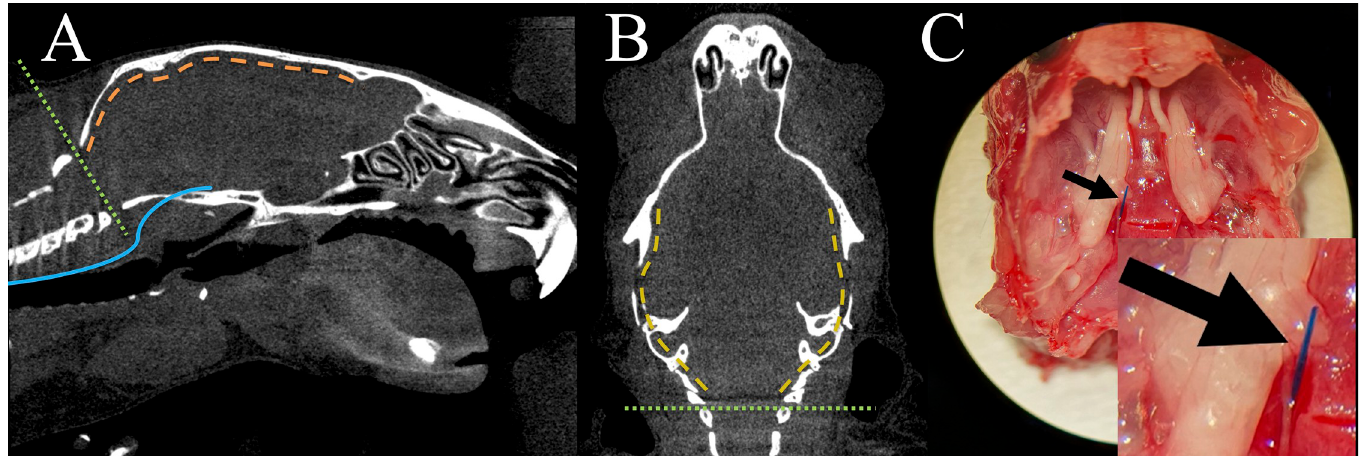
Fig 1. Sagittal ( A ) and transversal ( B ) reconstruction of a micro-CT image from a C57Bl/6-mouse. Because the filament used for perforation ( A , blue line ) runs at the skull base, the mouse was decapitated with a scissor along the green dotted line ( A, B ). Beginning at the foramen magnum the skull was opened with a blunt forceps by cracking it laterally on both sides ( B , yellow dashed line ) and finally the whole calvarium was removed ( A, orange dashed line ). After careful removal of the brain, the filament can be spotted at the site of perforation outside the vessel ( C, black arrow ).